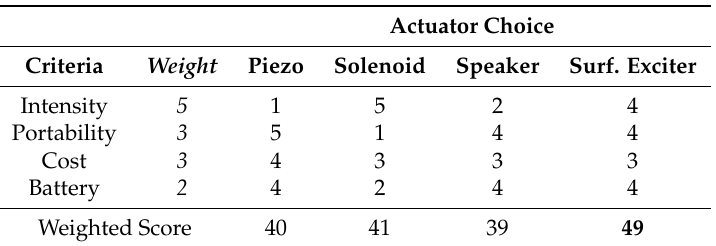
Table 2. Actuator Pugh chart: Scored from 1 (low) to 5